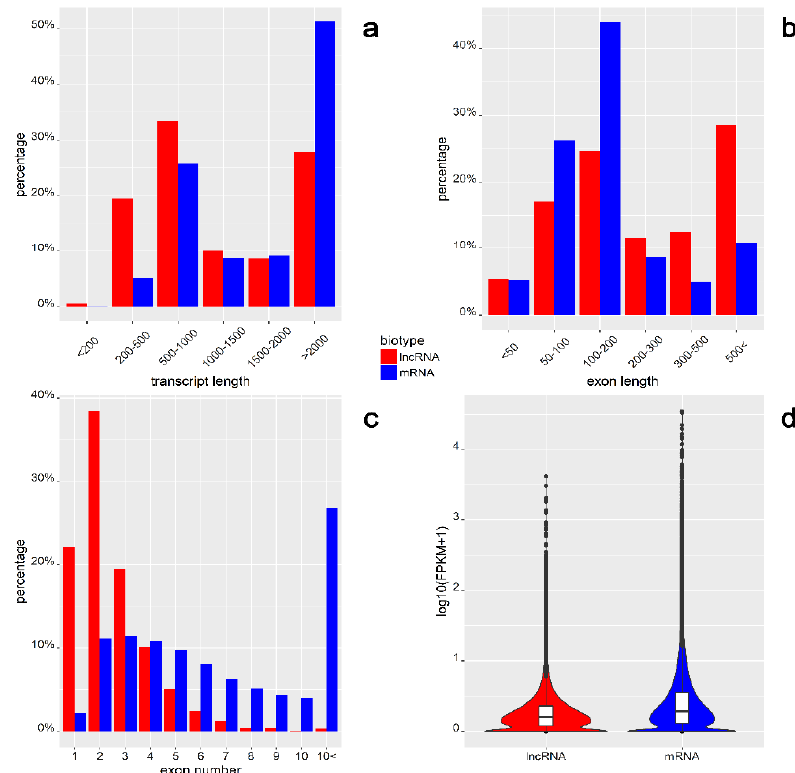
Figure 5. Global summary of comparison between lncRNA (red) and messenger RNA (mRNA) (blue) structural features. lncRNA and mRNA transcripts compared by ( a ) length; ( b ) exon length; ( c ) exon number; ( d ) expression level presented by log10(FPKM + 1); boxes inside each violin plot depict